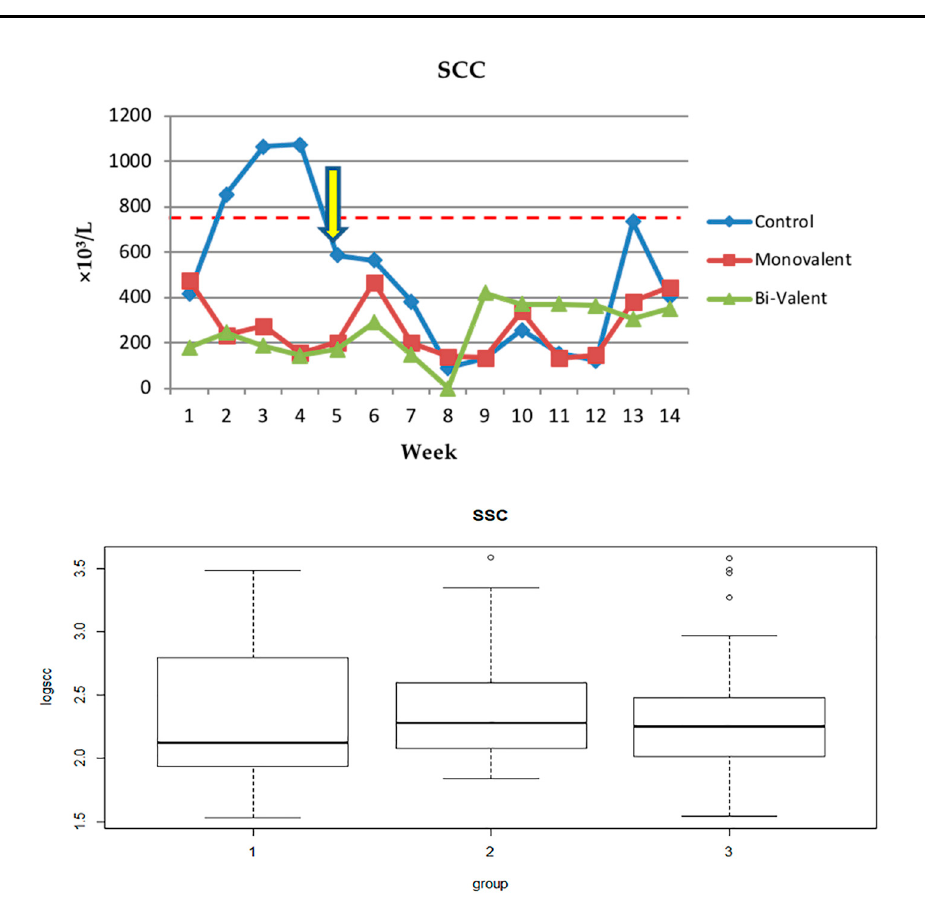
Figure 4. Results of SCC (graphs and boxplots). SCC: somatic cell count; group 1 (control), group 2 (mono-valent vaccine), group 3 (bi-valent vaccine). The red dotted line refers to the physiological threshold of the parameter value in ovine species while the yellow arrow indicates the first decrease in SCC after the placebo administration below physiological threshold.